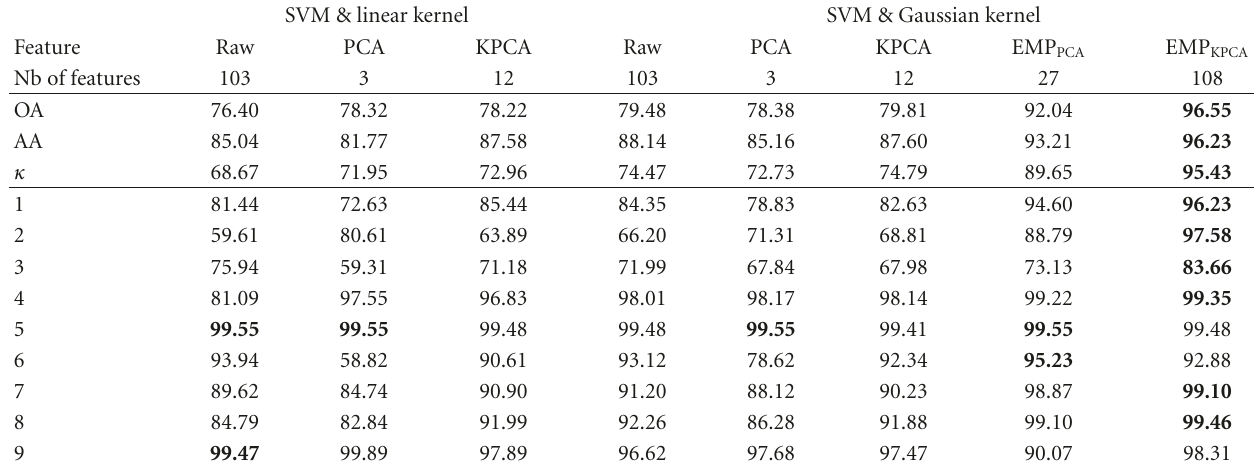
Table 6: Classification results for the University Area data set.